Question: Provide a one-line summary of what is displayed.
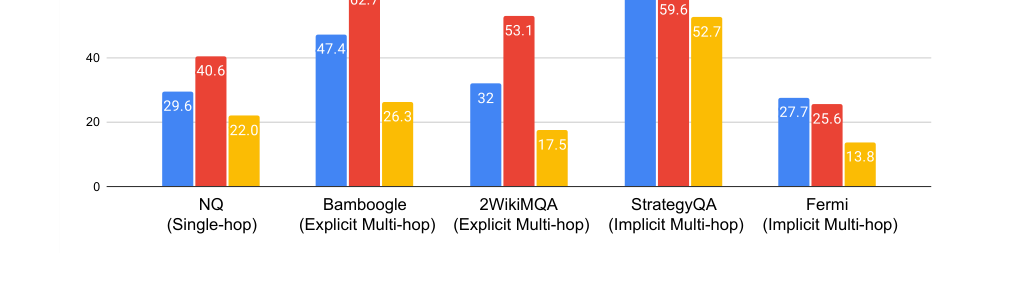
Answer: Accuracy for Llama-2-13B few-shot prompted on five QA tasks, in three settings: (a) without retrieval, (b) with top-1 retrieval from a strong search engine, and (c) with a randomly- retrieved passage. Retrieval augmentation can boost performance, but even strong retrieval hurts performance on StrategyQA and Fermi, and random contexts reduce performance dramatically.